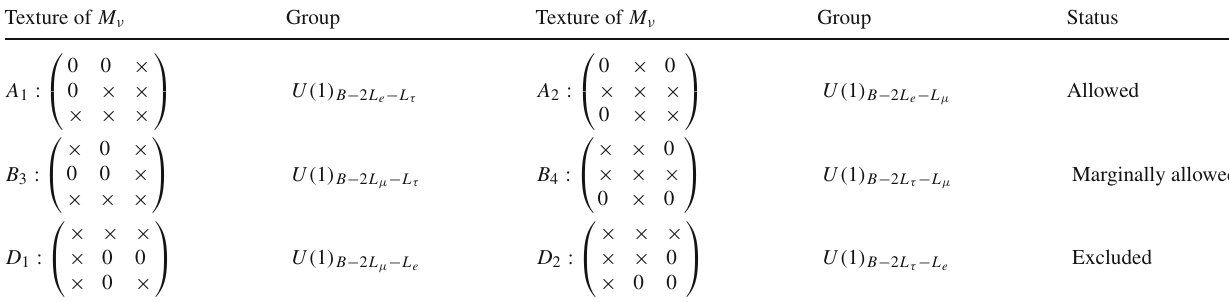
Table 2 Two texture-zeros and corresponding U ( 1 ) B − 2 L α − L β symmetry. Here, × denotes a nonzero matrix element Texture of M ν Group Texture of M ν Group Status